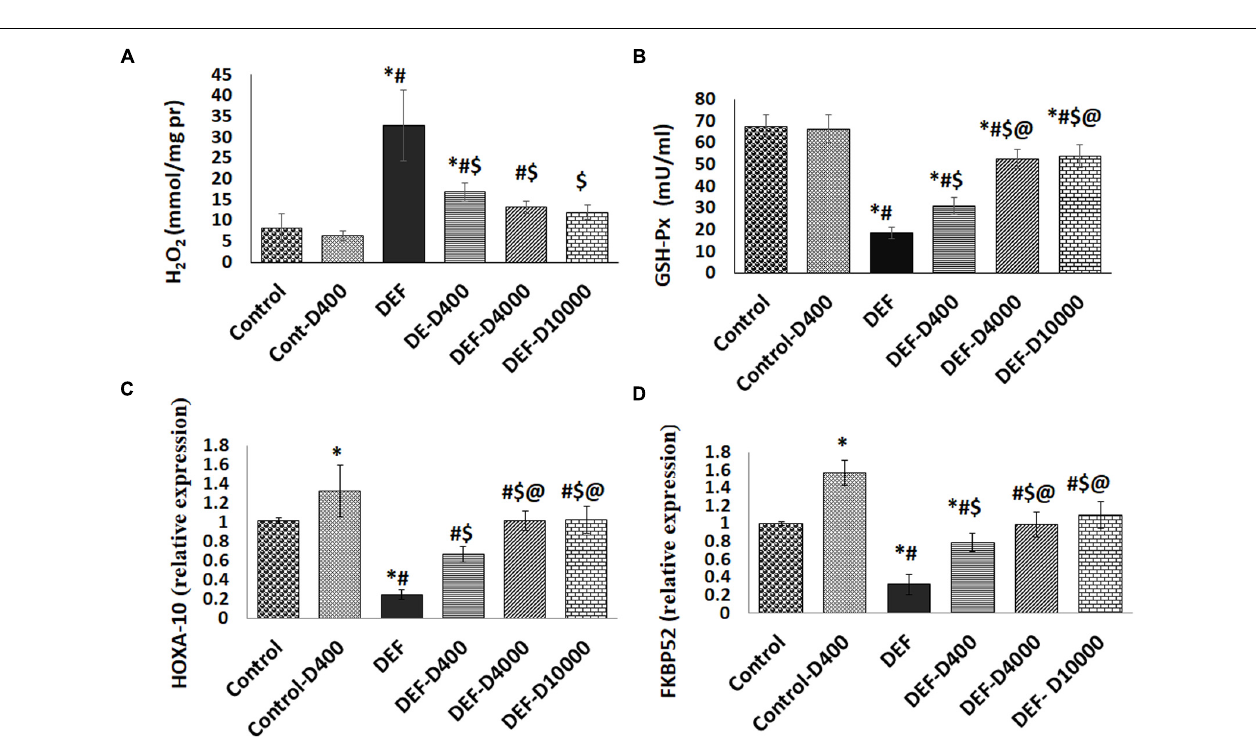
FIGURE 4 | Represents the levels of (A) H 2 O 2 , (B) Glutathione peroxidase activity (GSH-Px) in uterine tissues, and the expression levels of (C) Homeobox transcription factor (HOXA-10), as well as (D) Immunophilin FK506-binding protein 52 (FKBP52). D: refers to vitamin D supplementation in different doses equivalent to 400, 4,000, and 10,000 IU. DEF: refers to vitamin D deficiency. ∗ : Statistically significant sign compared to the control group, # : compared to control-400, $: compared to deficiency group, and @: compared to DEF-400 ( P <